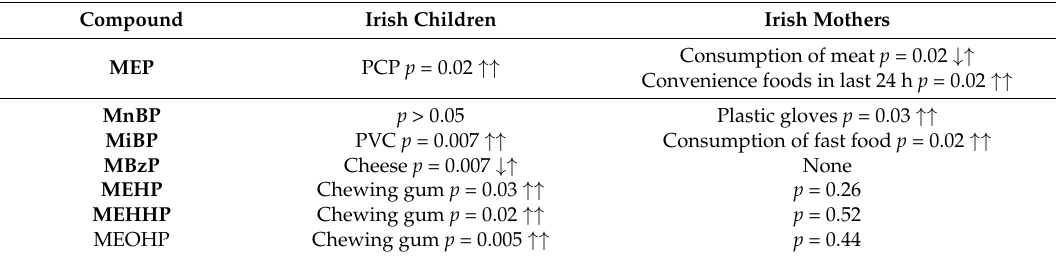
Table 5. Association between phthalate exposure and environmental